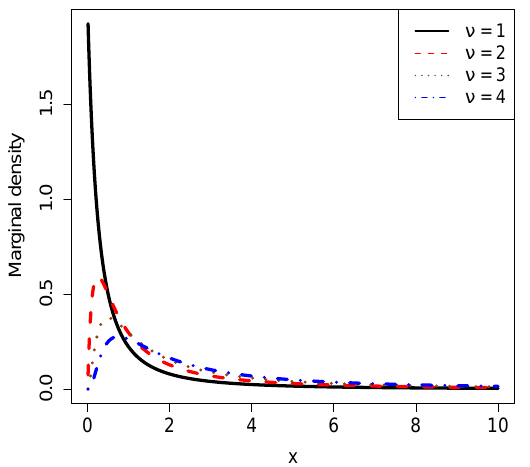
Figure 4. The marginal densities m 1 ( x | α , β , ν ) for varied ν = 1,2,3,4, holding α = 1 and β = 2